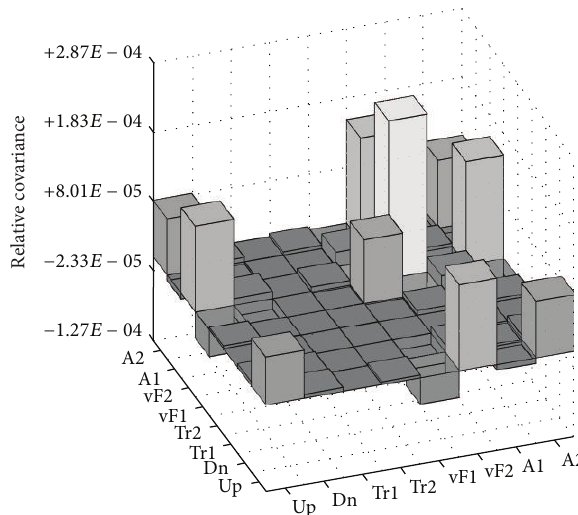
Figure 31: Homogenized property covariance due to 𝜎 U 235 𝑓 covari- ance using